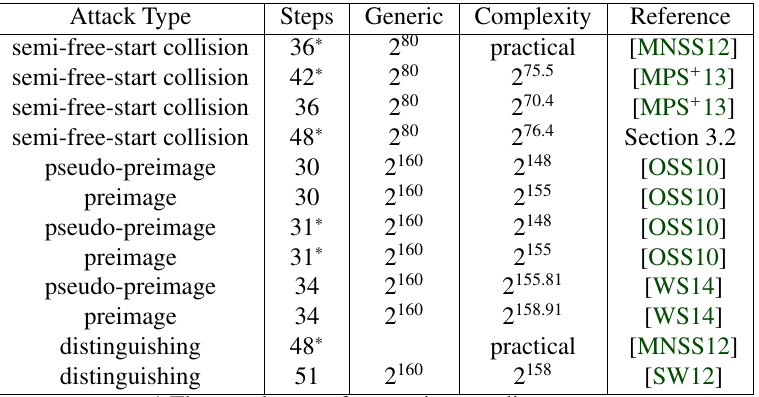
Table 1: Summary of the Attacks on RIPEMD-160 Attack Type Steps Generic Complexity Reference semi-free-start collision 36 ∗ 2 80 practical [MNSS12] semi-free-start collision 42 ∗ 2 80 2 75 . 5 [MPS + 13] semi-free-start collision 36 Section 3.2